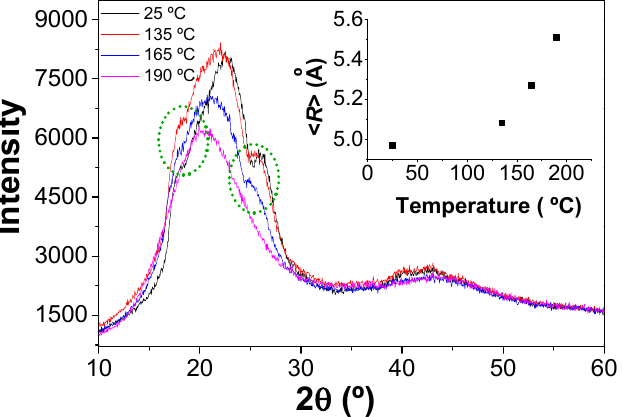
Figure 6. XRD spectra of IPCP-A film at different temperatures. Inset: the relationship between the interchain spacing and the temperature of the DRX.